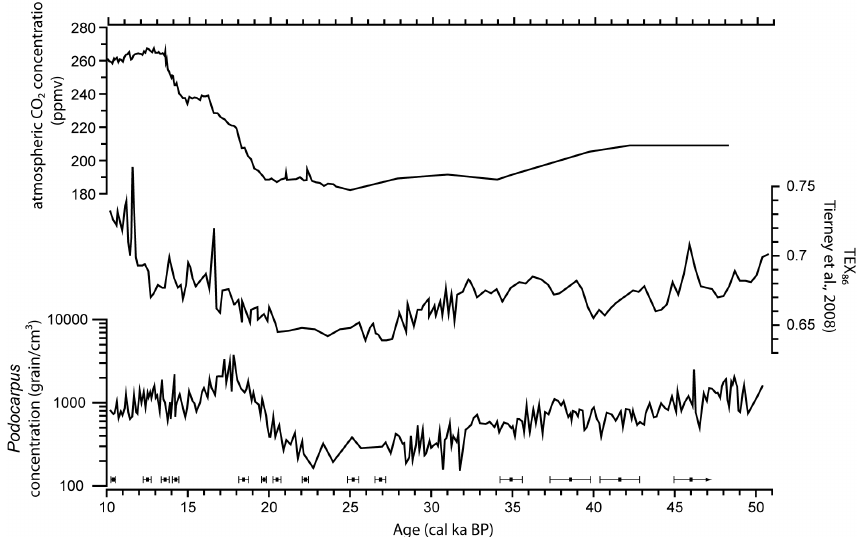
Fig. 4. Concentrations of Podocarpus (grains/cm 3 ) from ODP Site 1078 (bottom curve). Concentrations are given on log10 scale in [grains/ml]. TEX 86 (middle) is considered to represent the lake surface temperature of Lake Tanganyika , East African Rift system (Tierney et al., 2008). Uppermost curve is a composite record of atmospheric CO 2 concentration (Petit et al., 1999; Monnin et al., 2001) on the EDC3 time scale (EPICA, 2006). Timespans of calibrated C 14 age (Kim et al., 2003; R¨uhlemann et al., 2004; Dupont et al., 2008) are indicated on top of the time